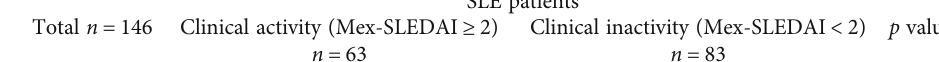
Table 1: Clinical characteristics by clinical activity in SLE